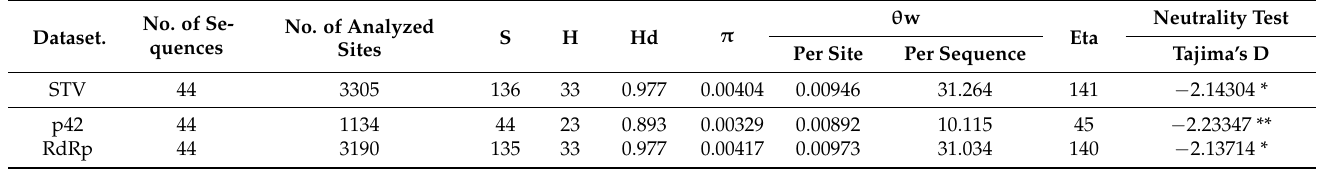
Table 2. Estimation of molecular genetic diversity among full genomes and individual genes (p42 and RdRp) of STV isolates.